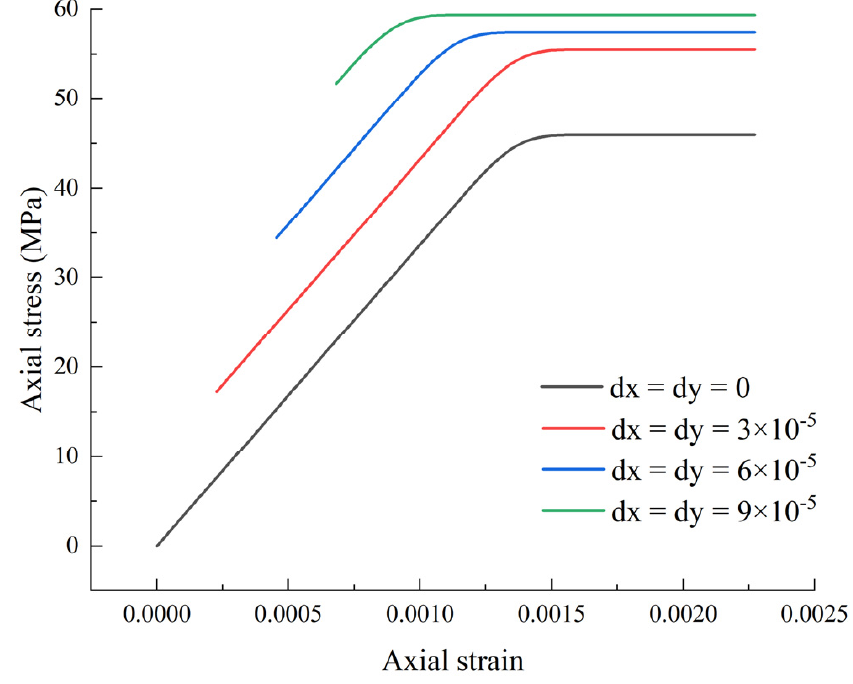
Figure 3. Stress–strain diagram of volcanic model, dx and dy is the x and y axial displacement.